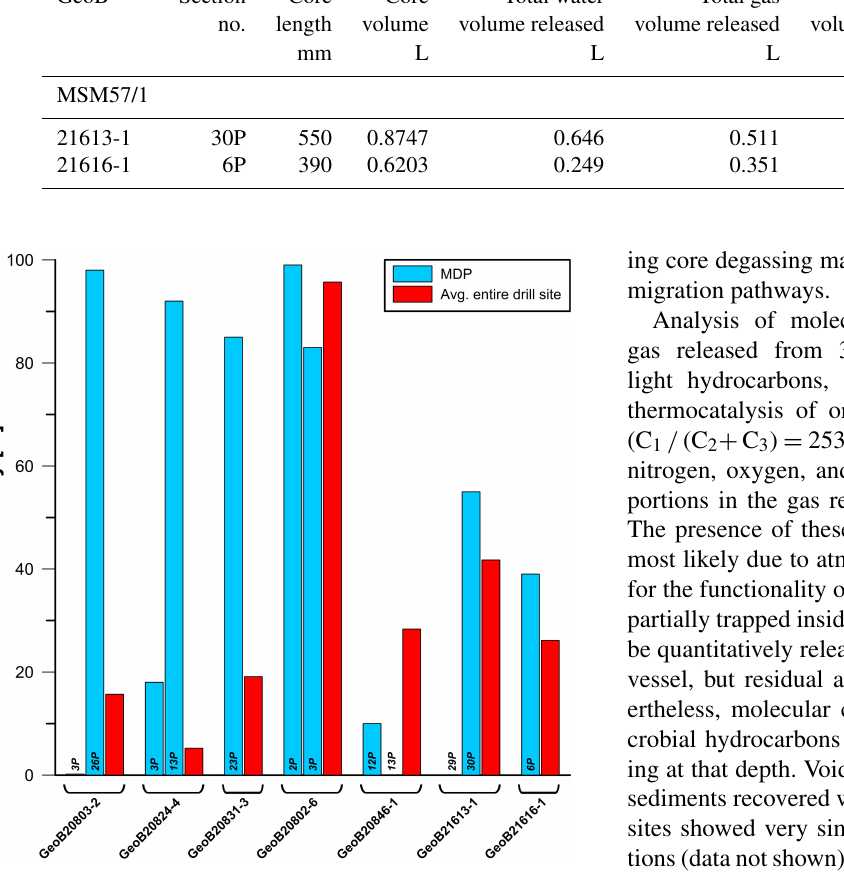
Figure 3. Comparative overview of average core recovery rates at individual drill sites (considering conventional core barrels and MDP, in red) and recovery rates of single MDPs at same drill sites (in